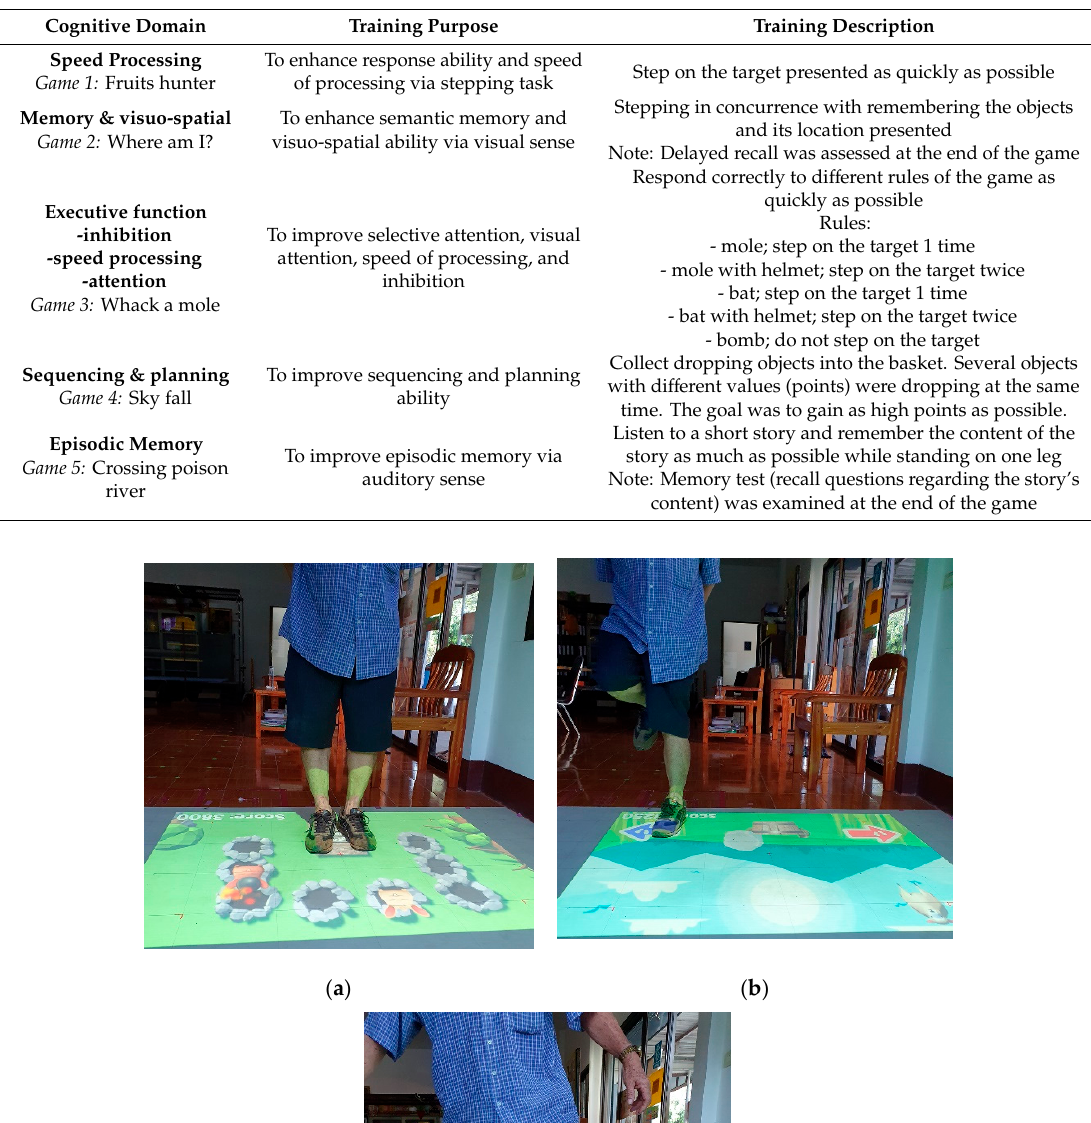
Table 1. Summary of the cognitive domain included in the combined physical-cognitive training program.